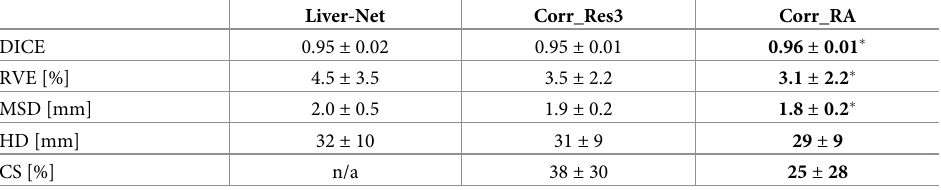
Table 2. Evaluation results (mean ± standard deviation) for the Liver-Net and for the liver masks corrected by Res3 and RA.